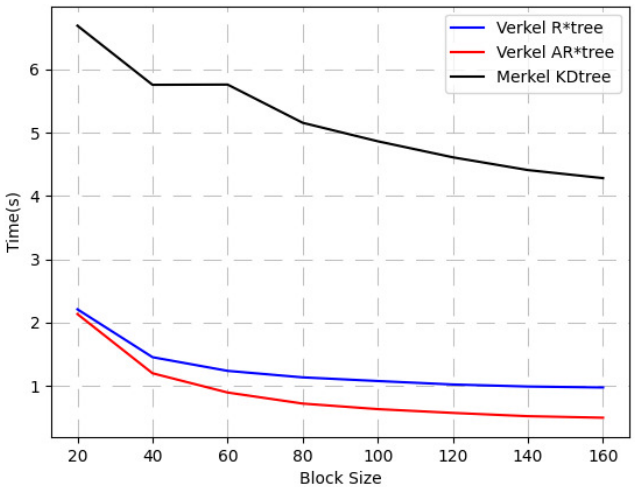
Figure 7. Query performance under different block sizes for point objects.